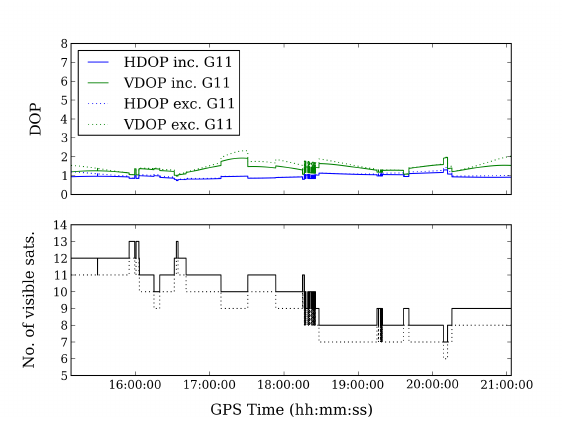
Figure 7: Horizontal and vertical dilution of precision (HDOP and VDOP) and number of visible satellites during the period 15:17 – 21:04 (GPS system time) on August 31 2013 at station UCL. Solid lines indicate the scenario of no satellite outage; dotted lines for the simulated